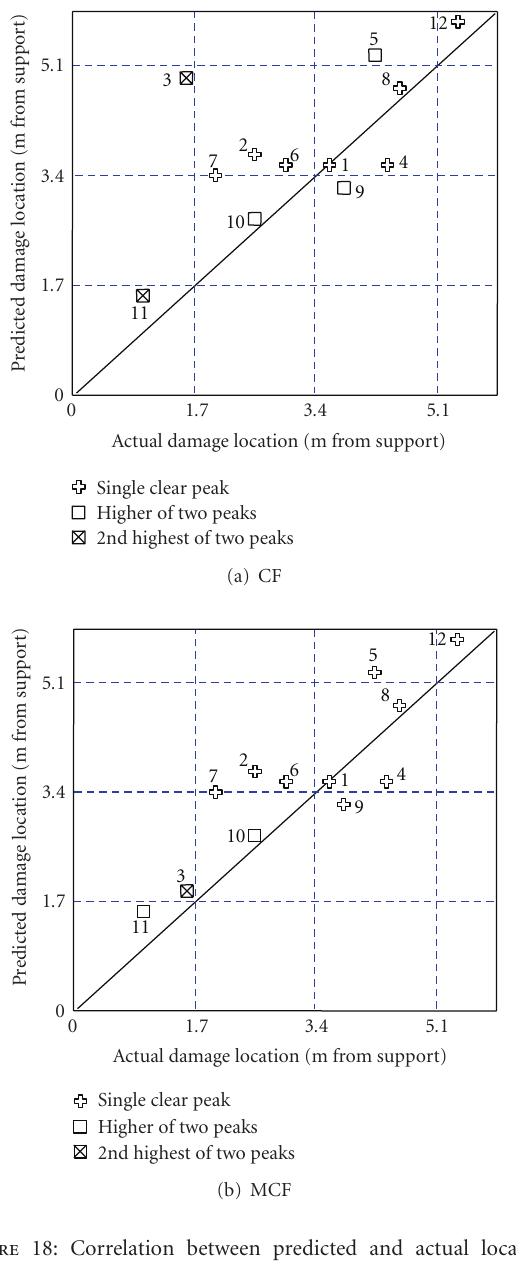
Figure 18: Correlation between predicted and actual location of experimental damage cases using six measurement points, calculated by the CF method in (a) original and (b) modified forms. Data points are numbered according to the experimental damage cases shown in Figure